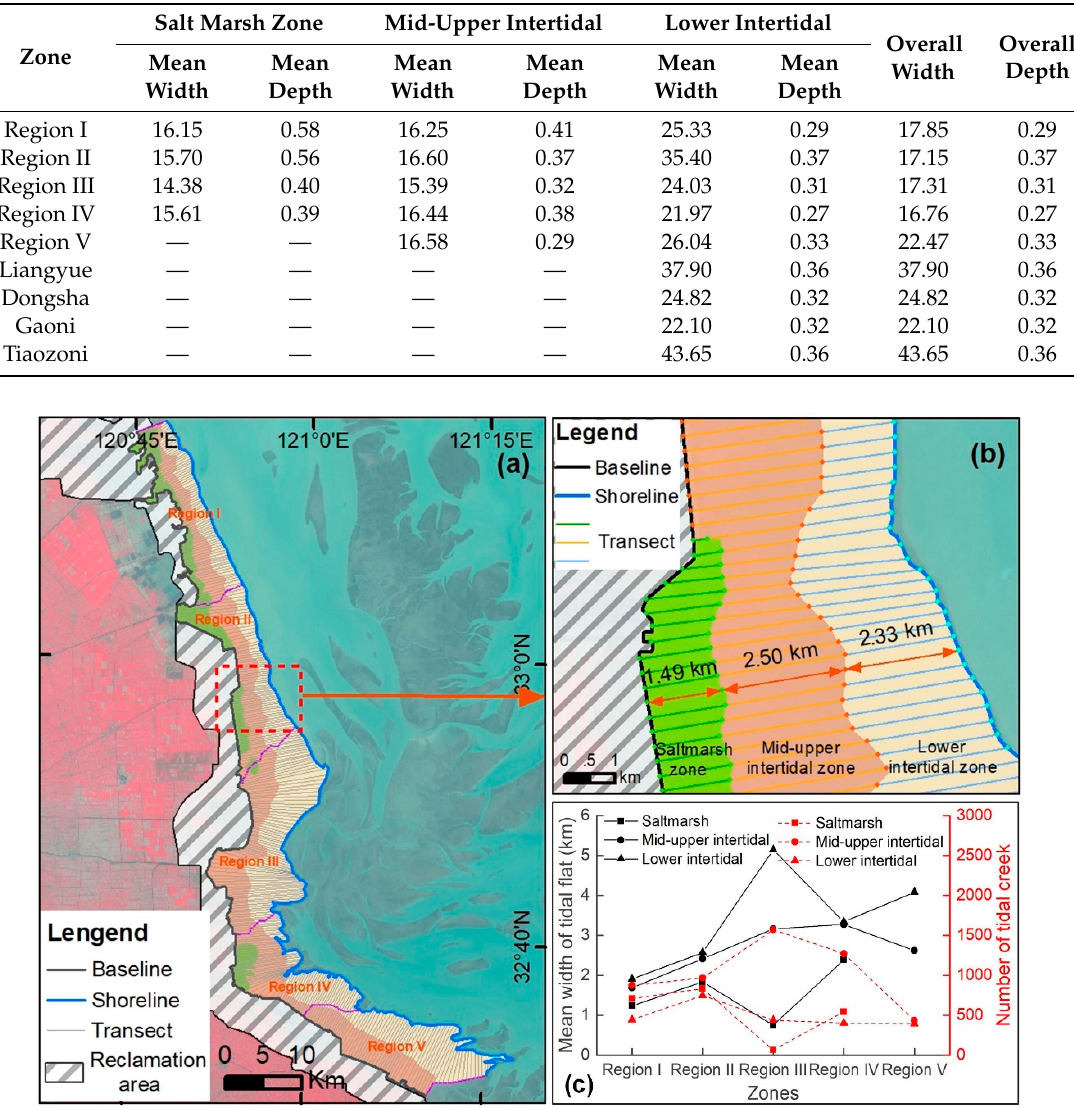
Figure 10. Comparison of tidal flat width and tidal creek number in different zones. ( a ) The vertical lines perpendicular to the baseline are generated at 300-m intervals along the coastline. ( b ) Enlargement of the area of the red dashed rectangle in ( a ), and the width of the tidal flat in the E-W direction. ( c ) Relationship between the mean width of the tidal flat (black symbols lines) and the number of tidal creeks (red symbols lines) for each region in the coastal area.